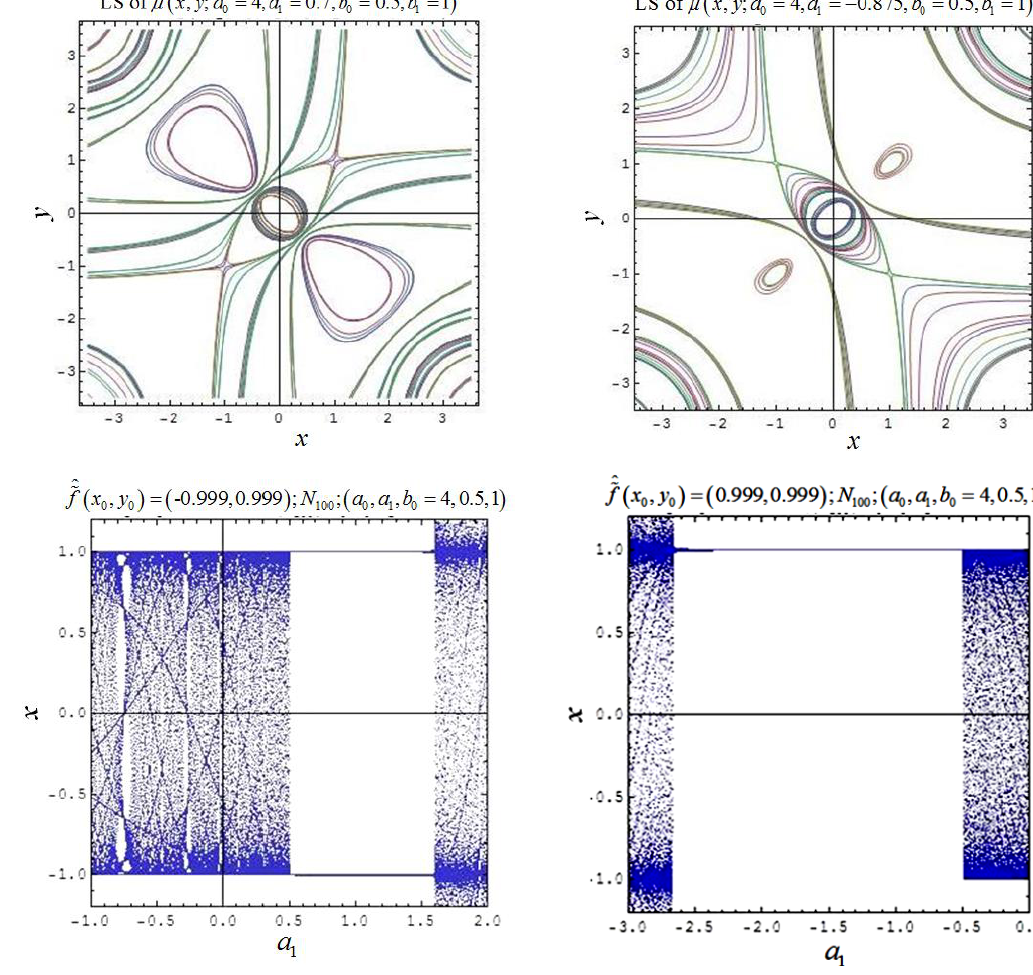
Figure 3. The level set forms of the integral (12) for the parameter value 𝑎